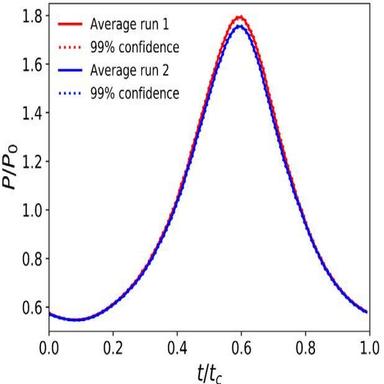
Average experimental pressure and 99% confidence interval for two independent CO2 experimental runs. The only difference between run 1 and run 2 is that the two pistons are swapped, i.e. run 1 has u = 0.5p and run 2 has u = 1.5p. Conditions: T0 = 30 C; u = 0.5p; Stroke1 = Stroke2 = 0–100 mm, tc = 4 s.